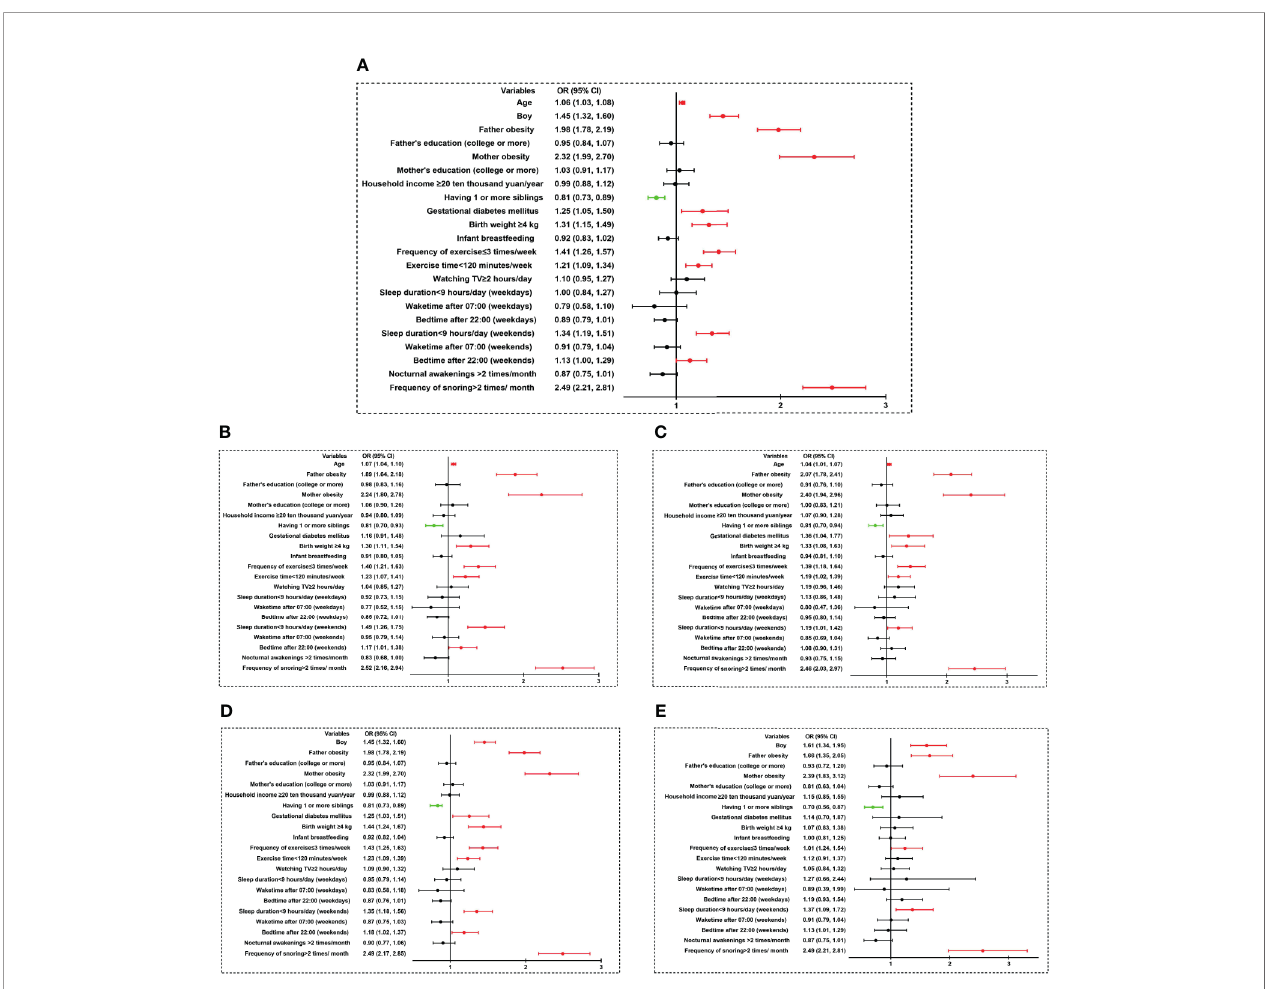
FIGURE 1 | Bivariate logistic regression analysis of sleep duration, sleep timing, and abdominal obesity. (A) all children; (B) boys; (C) girls; (D) children aged 7 – 12 years; (E) children aged 13 – 18 years). Variables that were signi fi cantly positively associated with abdominal obesity risk were shown in red color ( p < 0.05). Variables that were signi fi cantly negatively associated with abdominal obesity risk were shown in green color ( p < 0.05). OR, odds ratio; CI, con fi dence interval; TV,